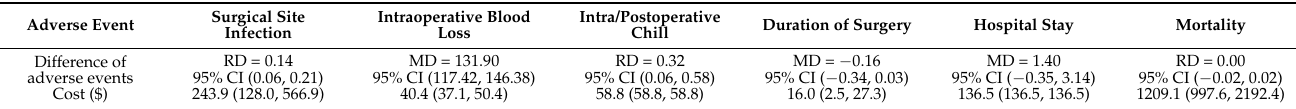
Table 2. Parameter ranges in the deterministic sensitivity analysis.